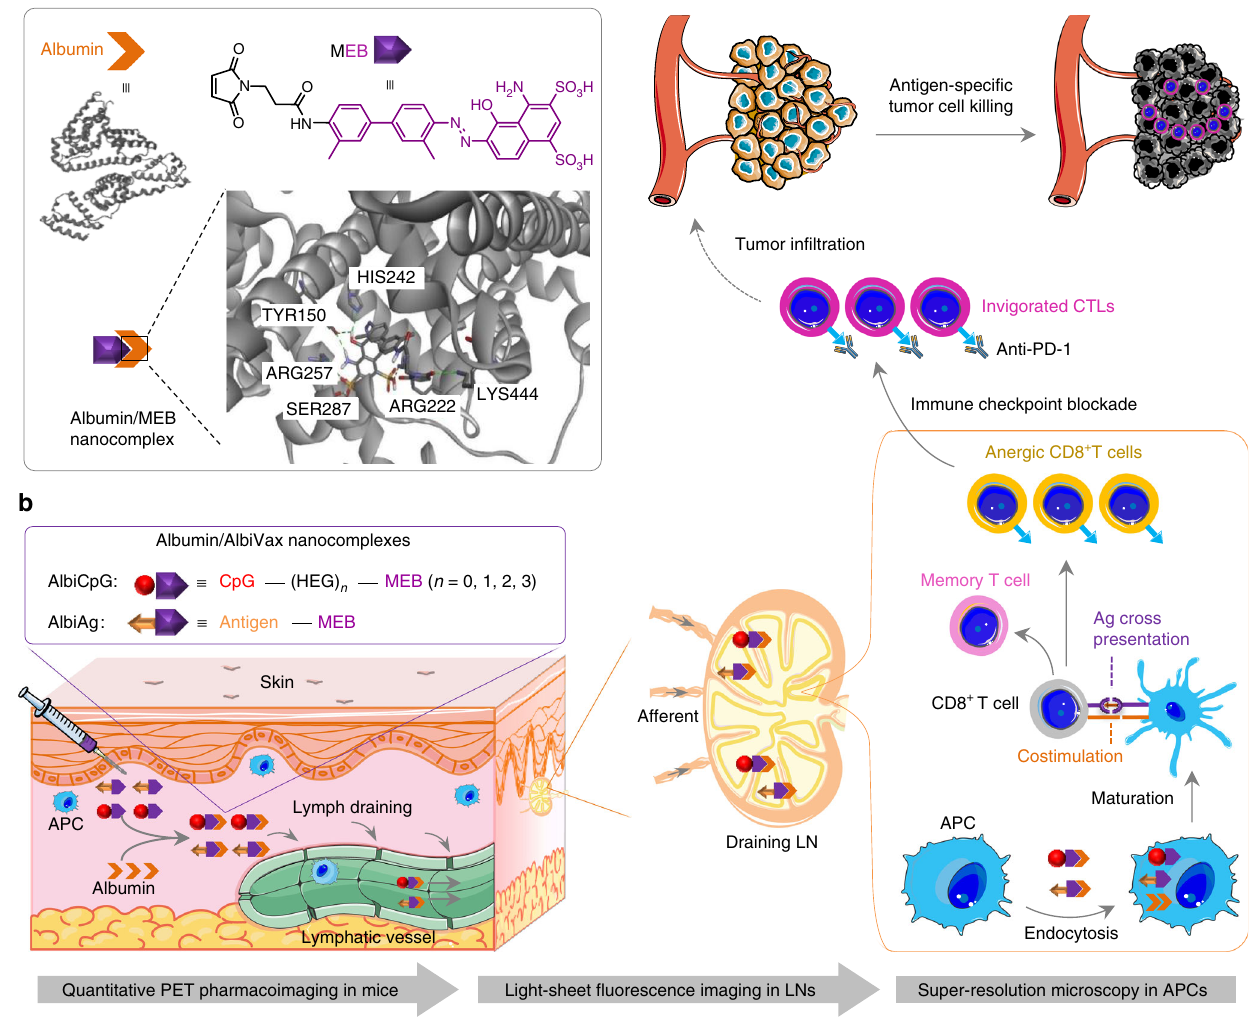
Fig. 1 Schematic of albumin/AlbiVax nanocomplexes for ef fi cient vaccine delivery and combination cancer immunotherapy. a Upper: structure of HSA (PDB ID: 2BXH) and chemical structure of MEB; lower: schematic structure of albumin/MEB nanocomplexes (left) and 3D molecular structure predicted by molecular docking (right). Sticks represent MEB and the amino acid residues in the binding site I of HSA. Green dashed lines represent hydrogen bonds between MEB and amino acids. b Working mechanism of albumin/AlbiVax nanocomplexes as potent T cell vaccines. Left box: modular structures of AlbiCpG and albumin-binding Ag (AlbiAg). AlbiCpG were engineered by site speci fi cally conjugating MEB and thiol-modi fi ed CpG, with hexaethyloxy- glycol (HEG) as tunable linkers; AlbiAg was synthesized by conjugating MEB and cysteine-modi fi ed Ags, including TAA and tumor-speci fi c neoantigen discovered via exome sequencing. Left lower: locally administered AlbiVax binds to endogenous albumin and assembles into albumin/AlbiVax nanocomplexes, which were ef fi ciently delivered to LNs due to lymphatic drainage and prolonged retention in LNs. Right: harnessing the endocytosis pathway of albumin, albumin/AlbiCpG and albumin/AlbiAg nanocomplexes were co-delivered into APCs and activated APCs for antigen cross presentation and clonal expansion of antigen-speci fi c CD8 + CTLs, thereby eliciting robust and durable antitumor immunity. While albumin/AlbiVax nanocomplexes upregulated the expression of PD-1 on these CD8 + CTLs, combination of albumin/AlbiVax nanocomplexes with anti-PD-1 dramatically enhanced immunotherapeutic ef fi cacy in established primary and metastatic tumors. The pharmacological behaviors of albumin/AlbiVax nanocomplexes were studied by quantitative PET imaging, light sheet fl uorescence microscopy in whole cleared tissue, and super-resolution imaging in single